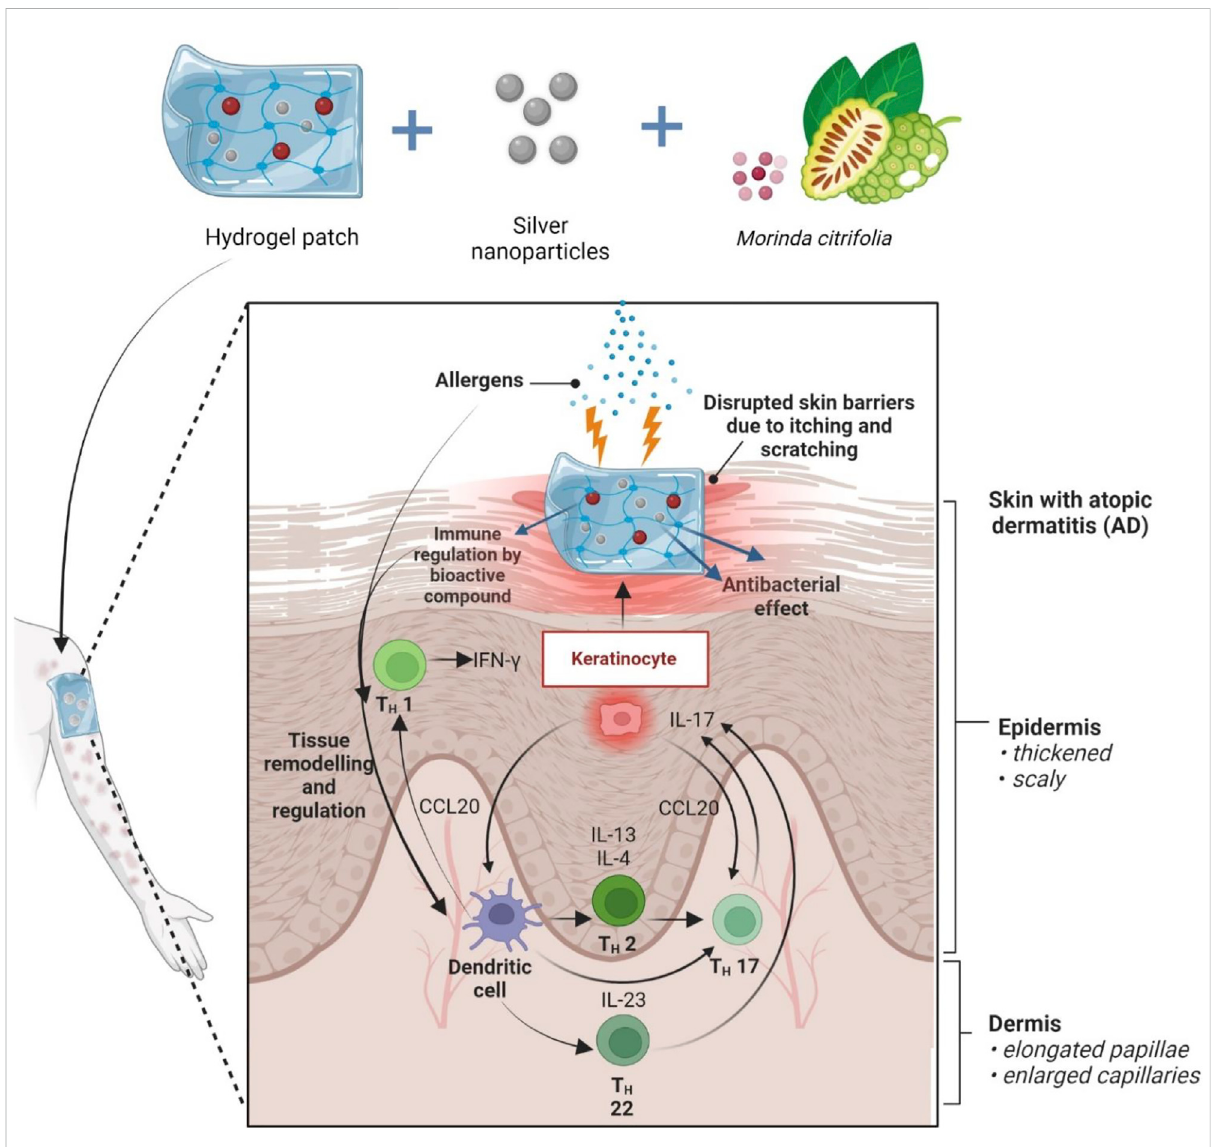
FIGURE 9 Future prospect of MCFE incorporated in hydrogel patch embedded silver nanoparticles. Allergens cause itching, which weakens the skin ’ s defenses. The fruitextractisthought to beableto regulatetheexpressionofTh1, Th2,Th17,and Th22-mediated cytokines includingInterleukin(IL)- 4,IL-5,IL-13,andIL-31inskinlesionsthatinduceaggravationofassociatedsymptomswithatopicdermatitis.Highertherapeuticef fi cacyisexpected when combined with